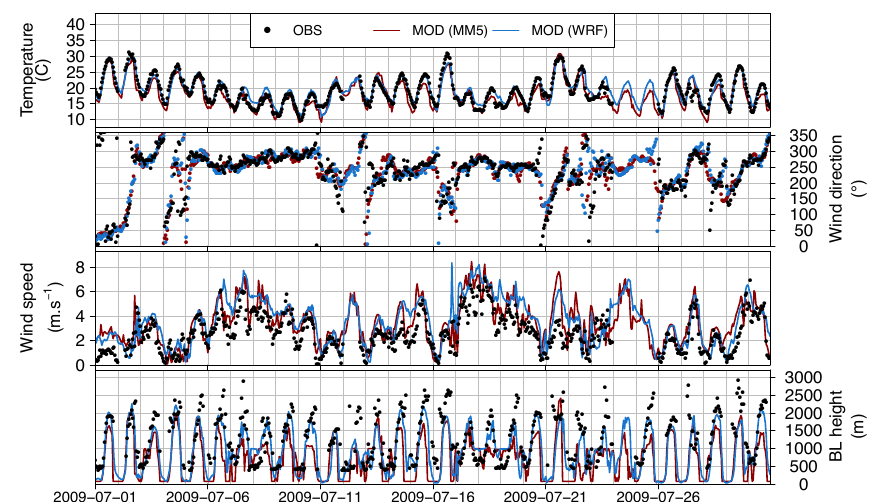
Figure 2. Wind (at 10m), temperature (at 2m) and BLH time series in July 2009 at SIRTA. Table 1. Statistical results of MM5 (and WRF in parentheses) considering all July hours and only the 06:00–14:00UTC time window ( N represents the proportion of available data).